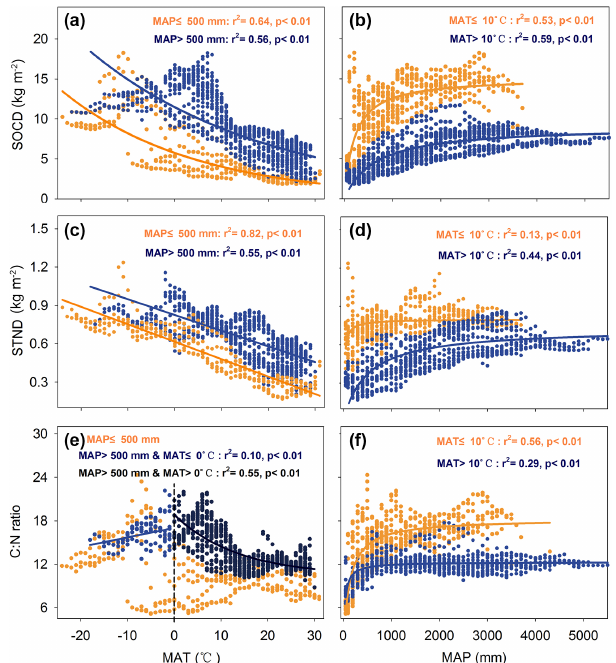
Figure 6. Changes in surface (0–30cm) soil organic carbon den- sity (SOCD), soil total nitrogen density (STND) and C : N ratios with mean annual precipitation (MAP) and mean annual tempera- ture (MAT). We used MAP of 500mm as a threshold of transition from arid to humid climate and MAT of 10 ◦ C as a threshold of tran- sition from cool to warm climate. (a, b) SOCD, (c, d) STND and (e, f) C : N ratios. Each dot shows the average value within each 1 ◦ C MAT and 100mm